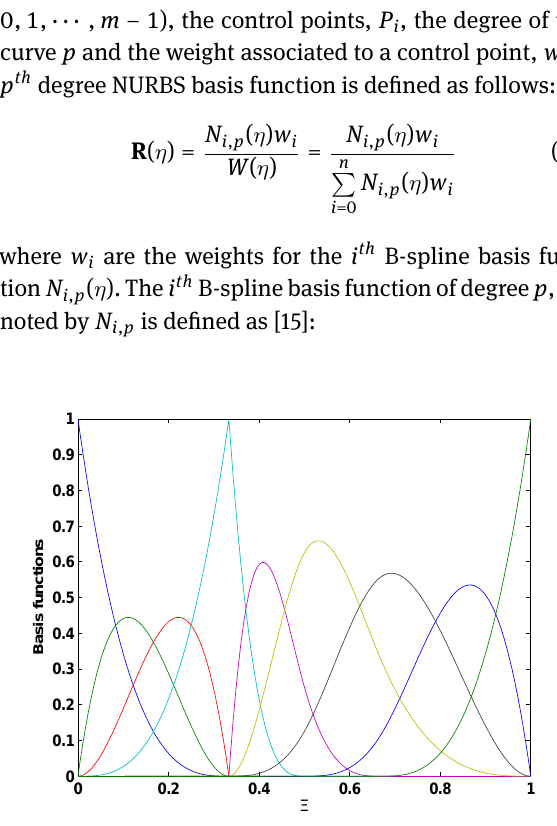
Figure 1: Non-uniform rational B-splines, order of the curve =